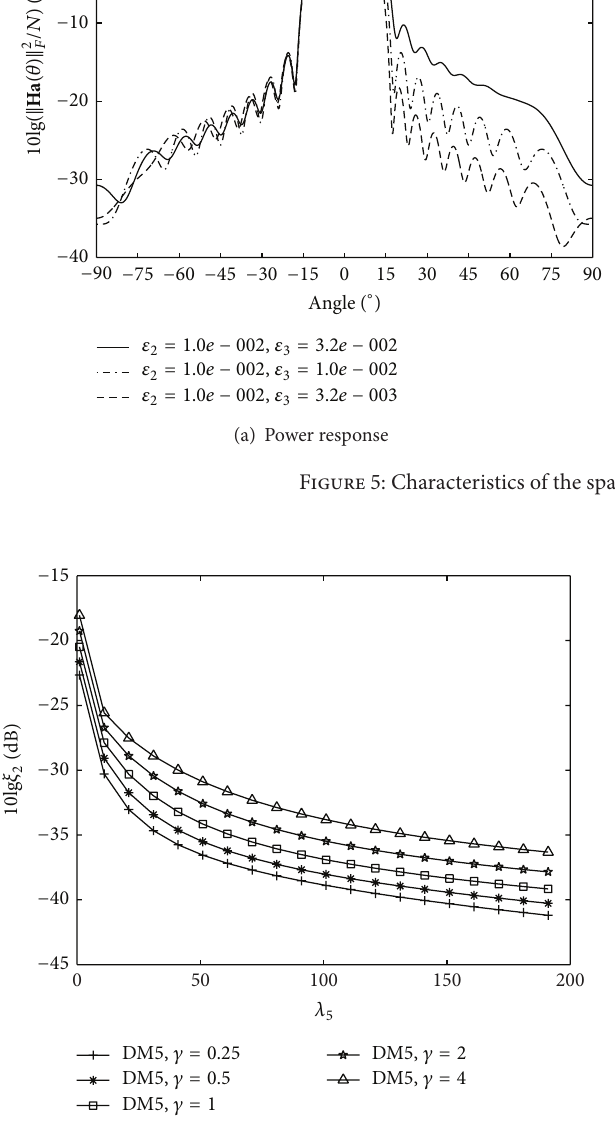
Figure 6: The relationship between the optimal Lagrange multiplier ̂𝜆 5 and the passband fidelity designed by